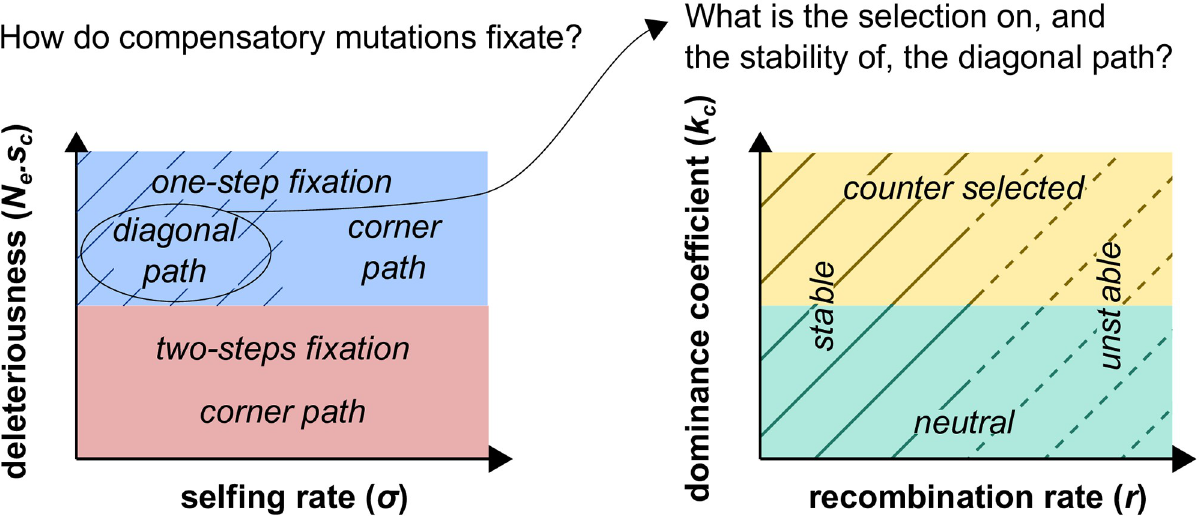
Fig 4. Fixation regime of compensatory mutations as a function of the selfing rate ( σ ), the strength of deleterious effect (deleteriousness), the recombination rate between the two loci ( r ), and the dominance coefficient in double heterozygotes ( k c ). Populations with high selfing rates always take the corner path on the fitness landscape ( i.e ., the deepest point of the fitness valley represented by genotypes that are homozygous for the ancestral allele at one locus, and homozygous for the derived allele at the other locus), while populations with low selfing rates can take the diagonal path ( i.e ., double heterozygous genotype). The diagonal path may however be counter selected (when k c is relatively high) and unstable (when the recombination rate is relatively high). Note that, for the sake of simplicity, all effects are here presented as discrete categories while they are in fact gradual.